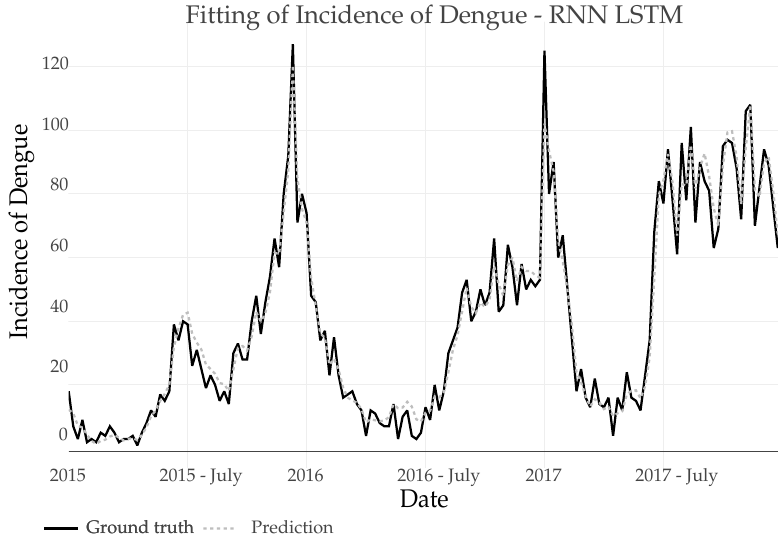
Figure 14. Fitting of Dengue Incidence for 3 years using a RNN-LSTM in-sample model and compar- ison with the real number of